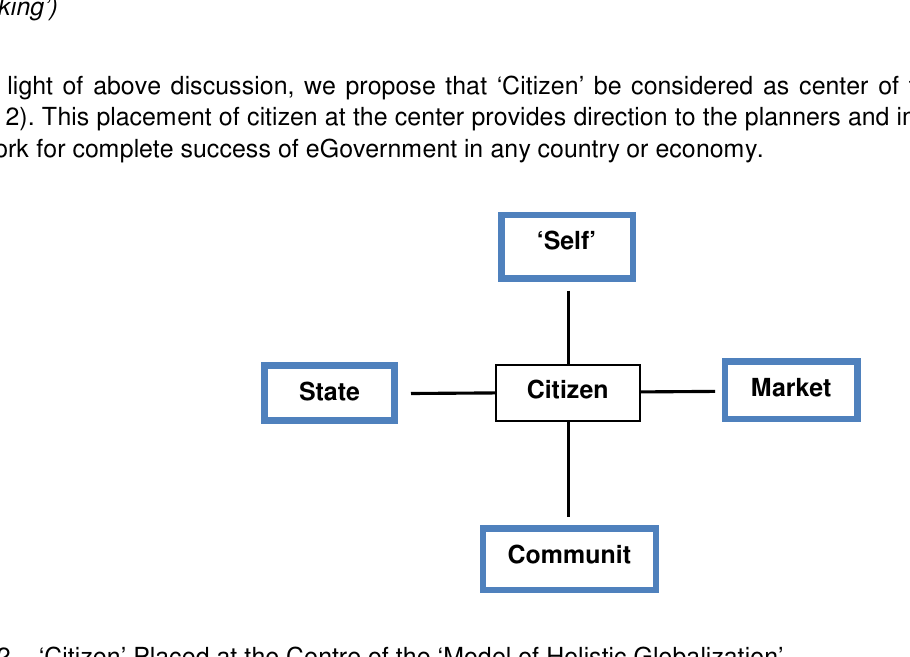
Fig. 2 – ‘Citizen’ Placed at the Centre of the ‘Model of Holistic